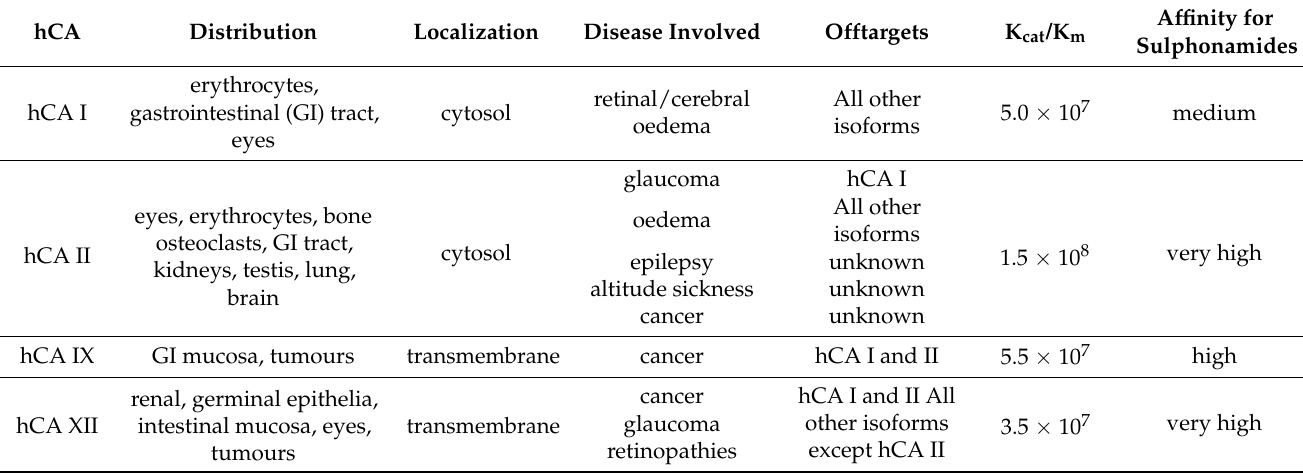
Figure 1. 3D multiple superpositions of four α -hCAs crystal structures (high sequence alignment homology) [23]. The multiple superpositions involved the following crystal structures: 1AZM (hCA I); 1ZFQ (CA II); 3IAI (CA IX); and 1JD0 (CA XII) with the Zn ion shown as red sphere, and its coordinating residues His 94, His 96, and His 119 shown in pink. The protein backbone is shown in green [1,20]. Table 1. Main CA isoforms considered here and their distribution, location, off-targets, kinetic parameter [K cat /K m (M − 1 s − 1 )], and affinity towards sulphonamides